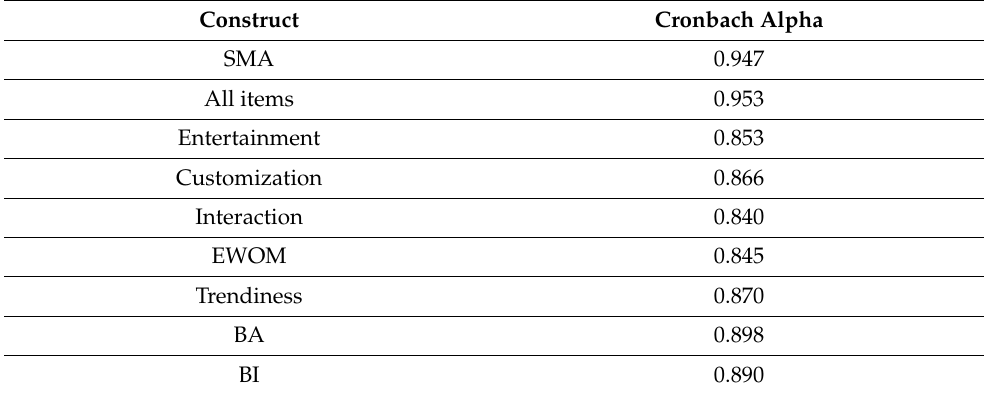
Table 1. Construct Reliability Results.